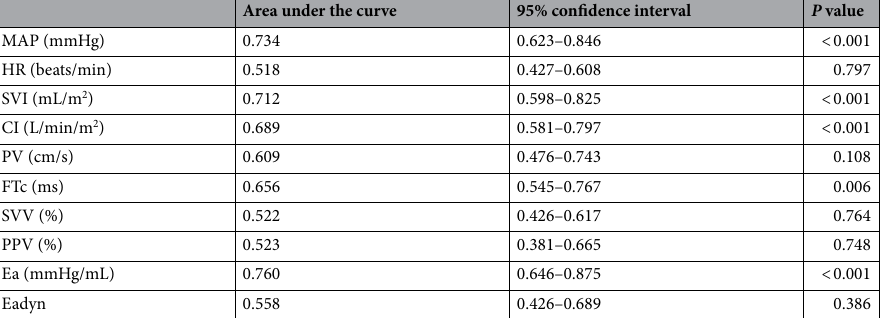
Area under the curve 95% confidence interval P